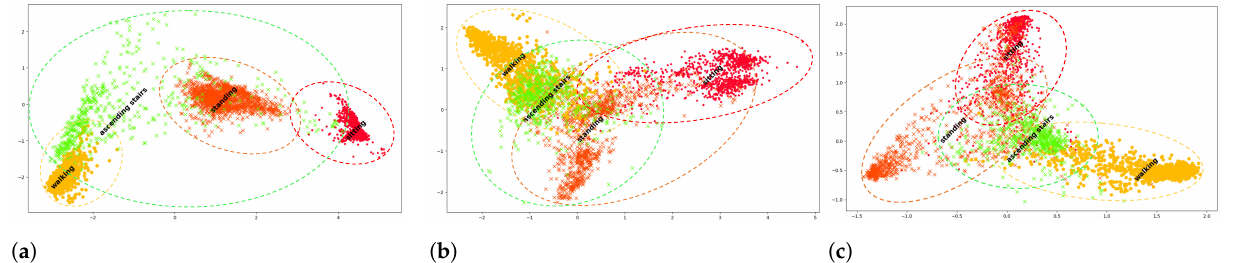
Figure 3. Feature embeddings of base classes—walking (yellow), sitting (red), standing (orange)— from PAMAP2 dataset learned during offline pretraining and new unseen class—ascending stairs (green). ( a ) After offline pretraining on base classes only: we observe how the feature spatial distribu- tion of new classes is incompatible with the base classes that are well-distinguished and separated. ( b ) After online finetuning of base and new classes: we observe overlap in the clusters belong to base classes compared to offline pre-training but a narrowing in the feature spatial distribution of the new class. ( c ) After continual learning of base and new classes using LAPNet-HAR : compared to online finetuning, we observe a more compact feature distribution when applying contrastive loss. We still observe some overlap in the class clusters especially for classes that share similar characteristics (such as sitting and standing). We observe some improvement in the new class cluster being separated from the base